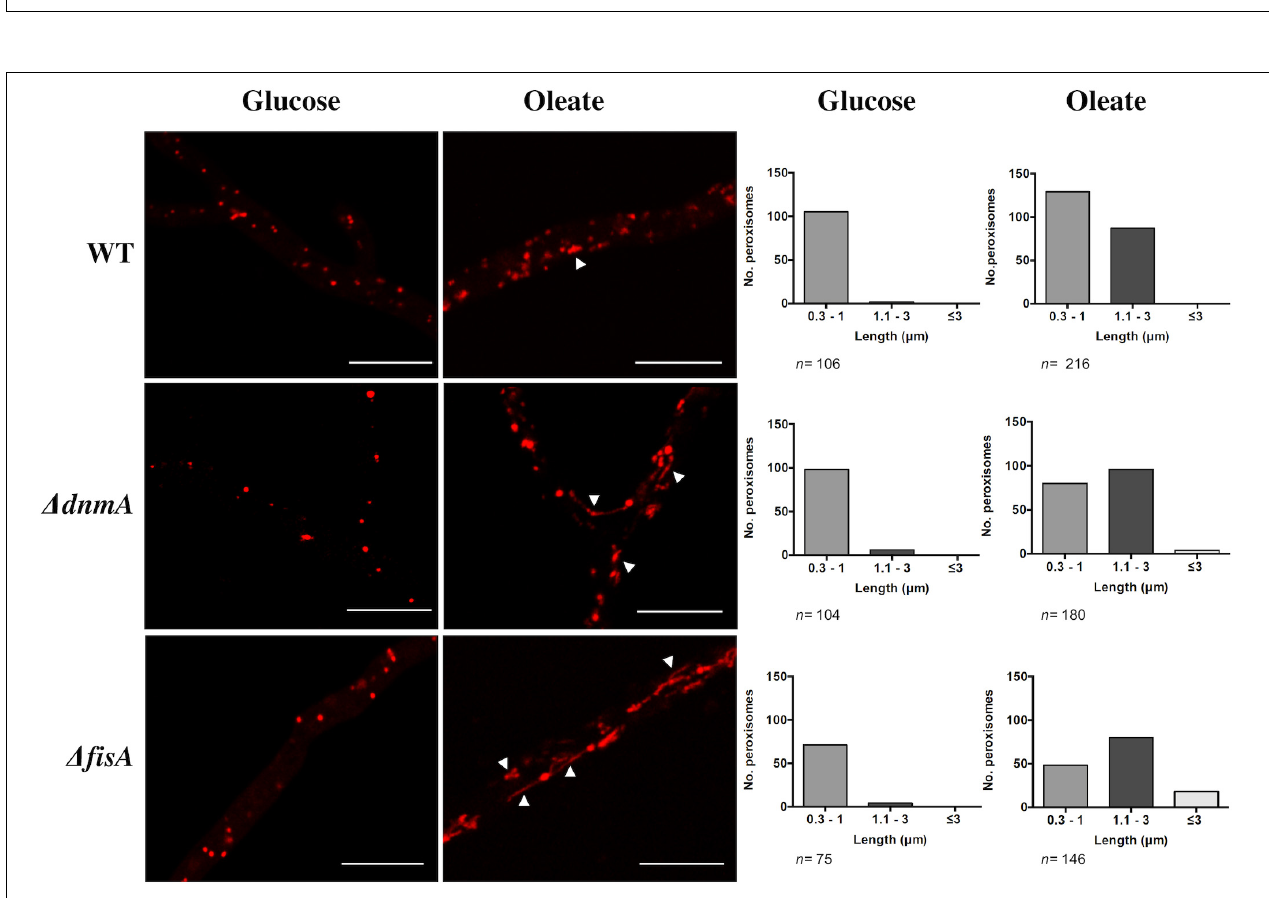
FIGURE 6 | DnmA and FisA regulate peroxisomal fission. Mycelia from strains RPA (WT), CVG30 ( (cid:49) dnmA ), and CVG31 ( (cid:49) fisA ) grown for 48 h on supplemented MM containing either glucose or oleate as sole carbon source was observed using confocal microscope (Left) . Peroxisome number was determined and, according to their length, peroxisomes were classified (Right) in categories short (0.3–1.0 µ m), medium (1.1–3.0 µ m), and long (more than 3 µ m). A representative experiment is shown. Arrowheads in (cid:49) dnmA and (cid:49) fisA mutants point to larger and filamentous peroxisomes. White bars = 10 µ m.